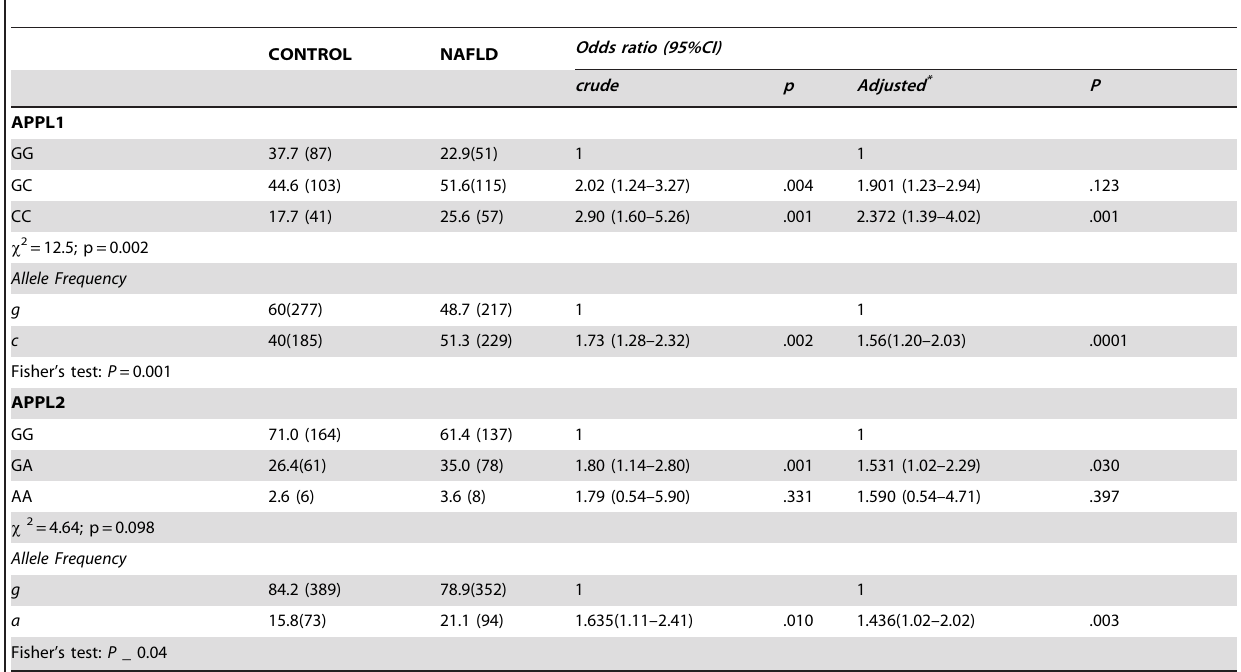
Table 2. Genotype and allele frequencies distribution of rs4640525- APPL1 and rs11112412-APPL2 in NAFLD patients and control.